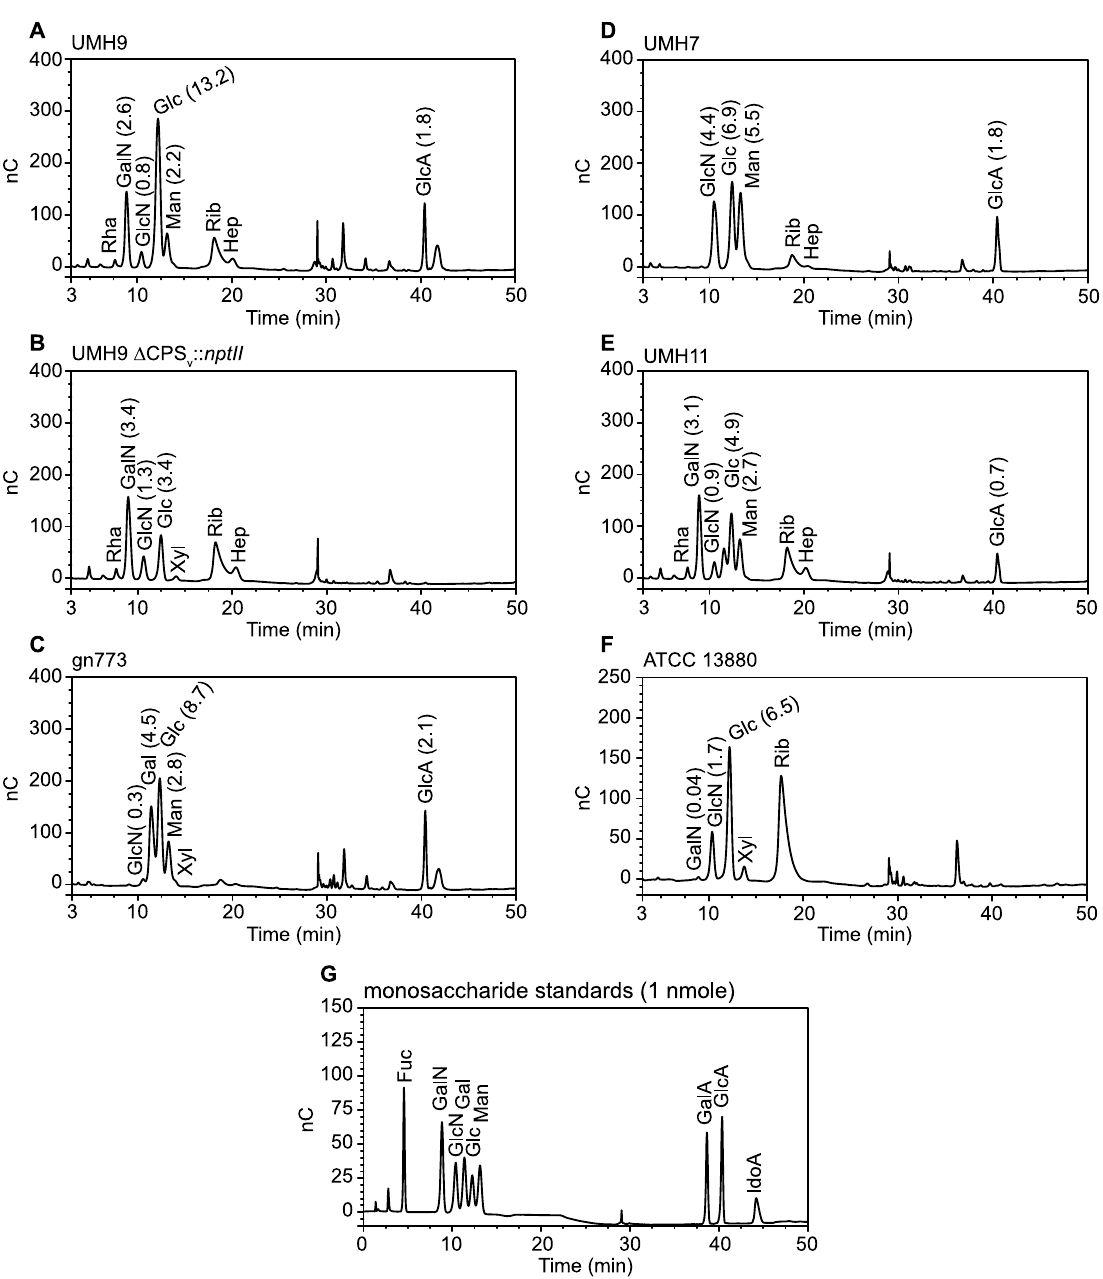
Fig 11. Identification of uronic acids in S . marcescens polysaccharide preparations. (A-F) Uronic acids and other monosaccharides were detected in 10 μ g preparations of S . marcescens CPS by HPAEC-PAD. The amount (nmole) of monosaccharides detected are shown in parentheses. G. Standards consisting of 1 nmole of selected monosaccharides were assessed simultaneously. Abbreviations: Fuc, fucose; Gal, galactose; GalA, galacturonic acid; GalN, galactosamine; Glc, glucose; GlcA, glucuronic acid; GlcN, glucosamine; Hep, heptose; IdoA, iduronic acid; Man, mannose; Rha, rhamnose; Rib, ribose; Xyl, xylose.